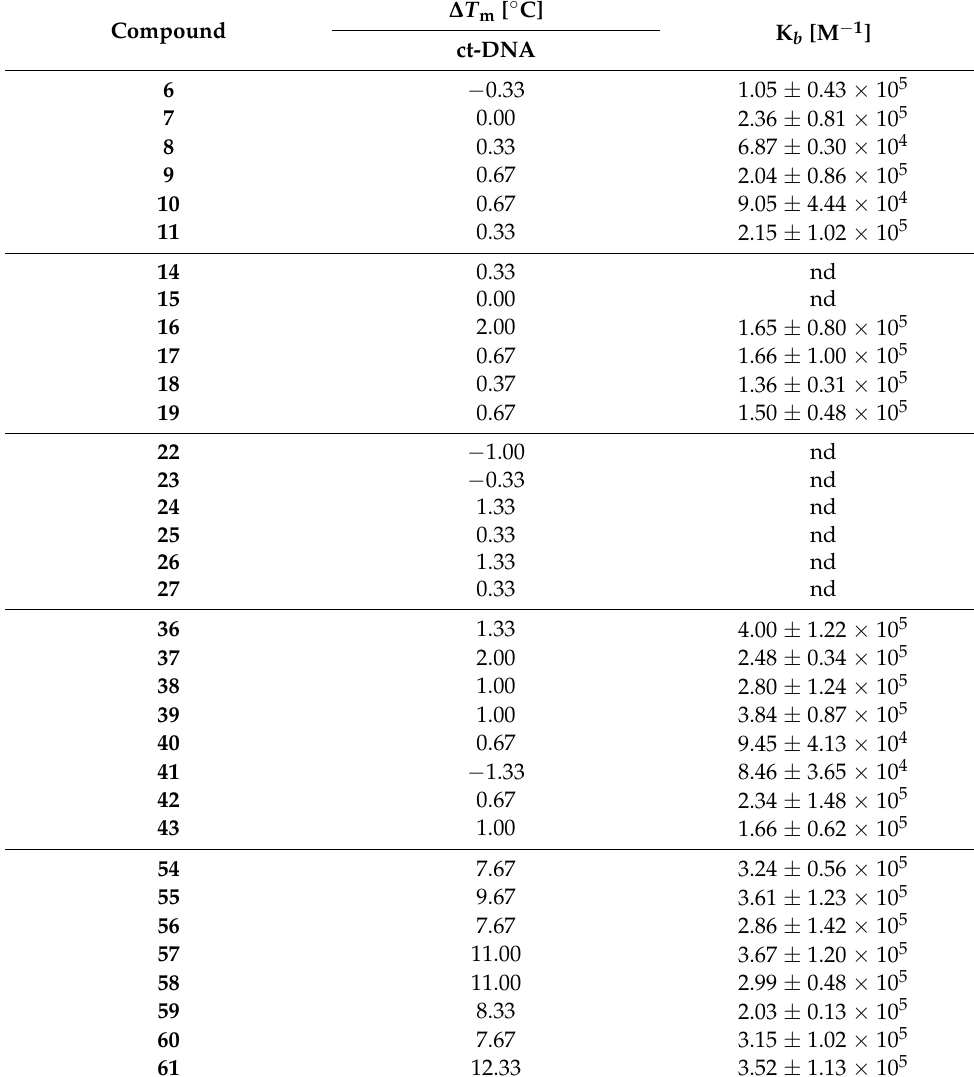
Table 1. ∆ T m and binding constant (K b ) based on UV–vis of ct-DNA in the presence of 1,8- naphthalimide–carborane conjugates. nd: no